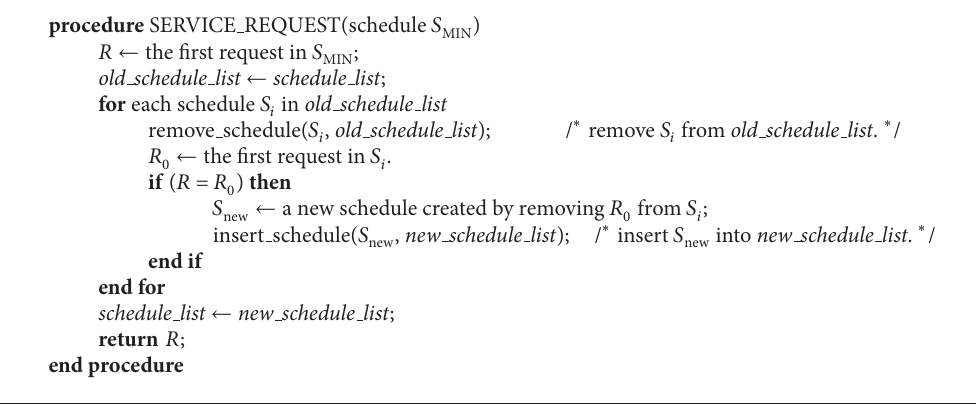
Algorithm 2: Dispatching a request from